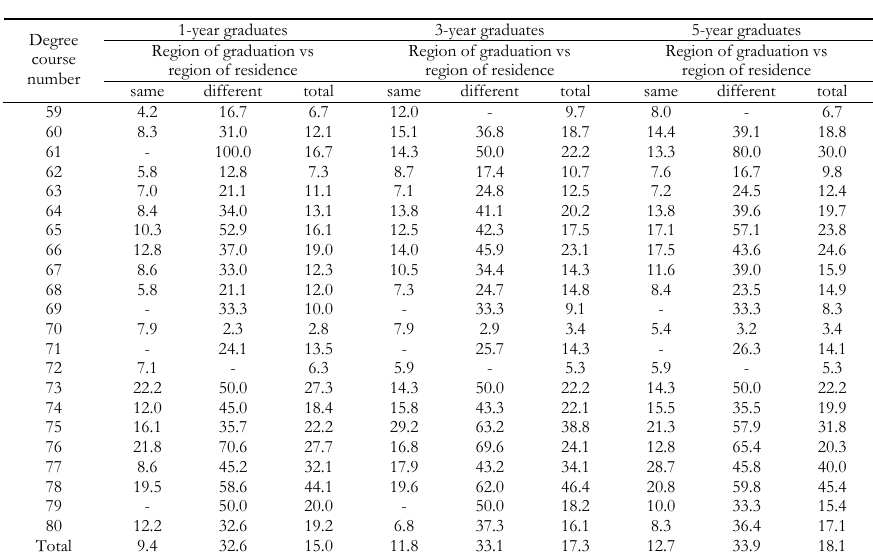
Source: measurements based on ALMALAUREA